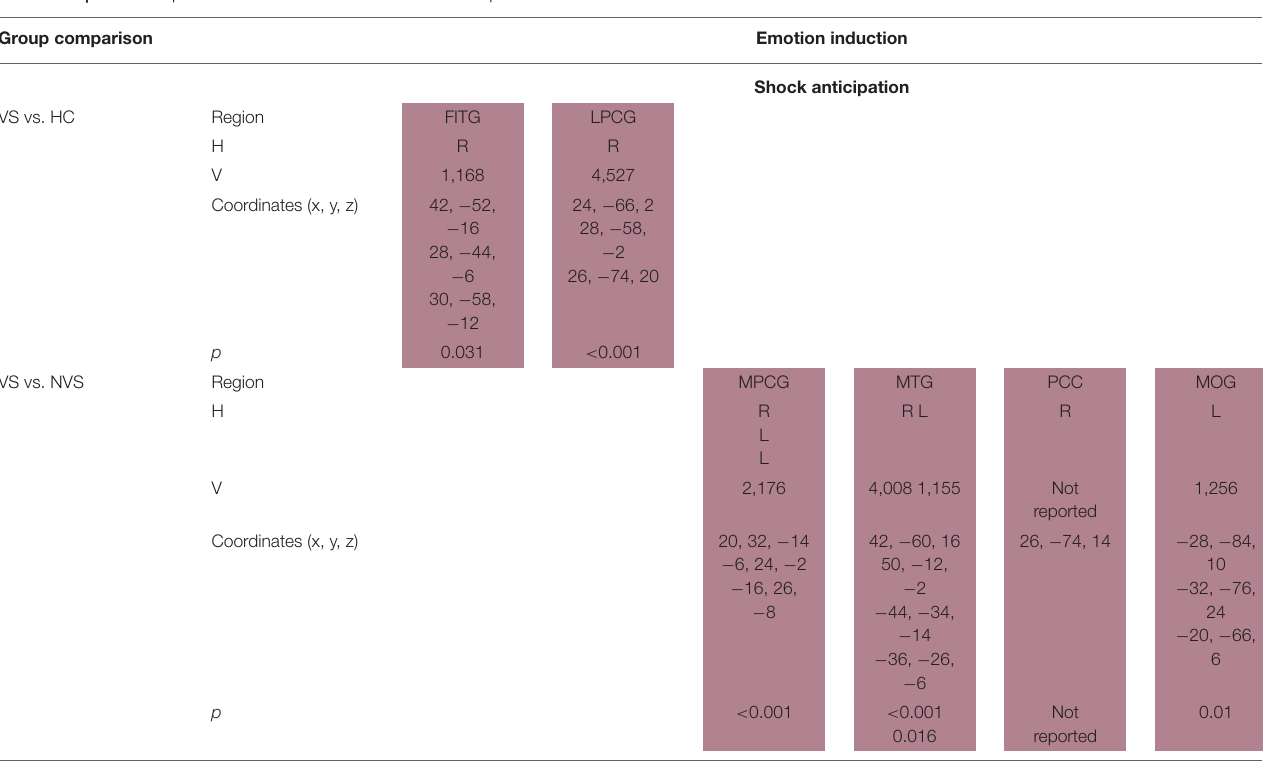
TABLE 5A | Activation patterns in emotion induction: shock